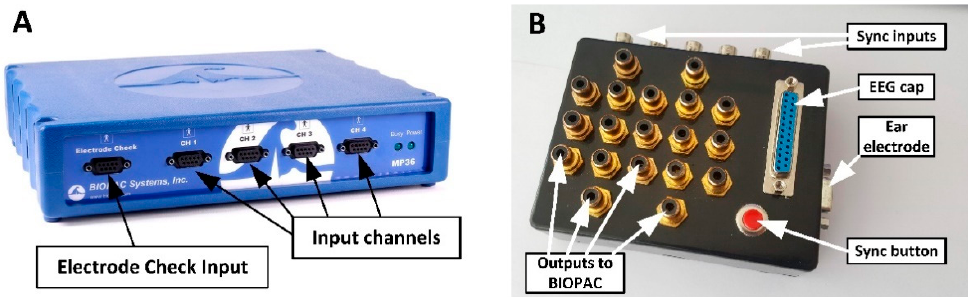
Figure 2. BIOPAC acquisition unit ( A ) and developed EEG headbox ( B ).